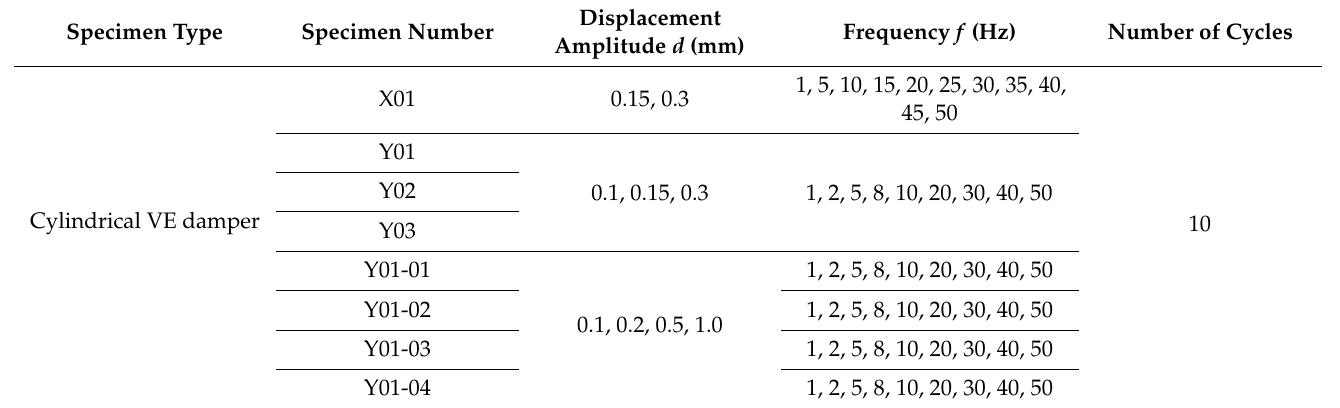
Table 2. Loading procedure of property tests on the viscoelastic dampers.